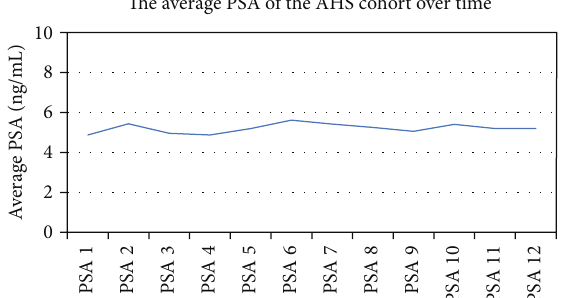
Table 6: Treatment options of the patients that discontinued ( 𝑁 = 26